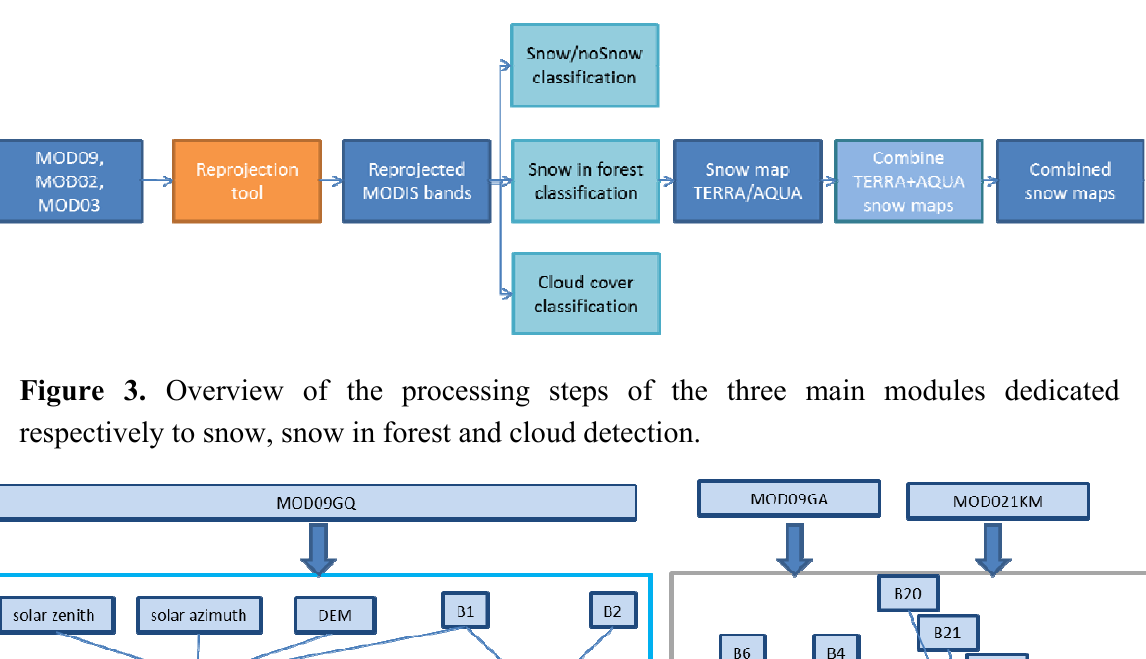
Figure 2. Overview of the processing steps for SCA map generation.